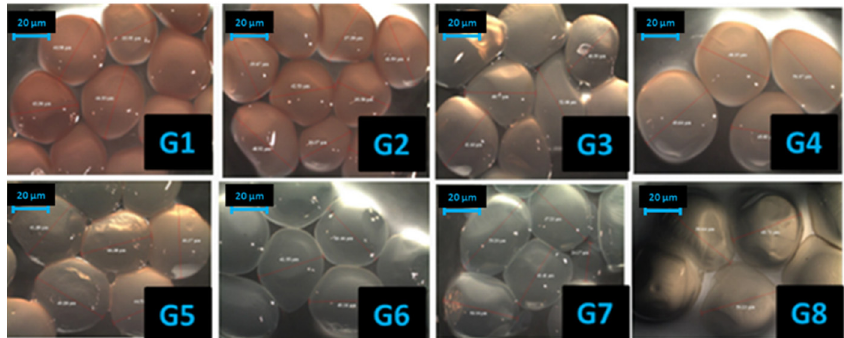
Figure 3. Optical microscopy image of the obtained microcapsules (100×).